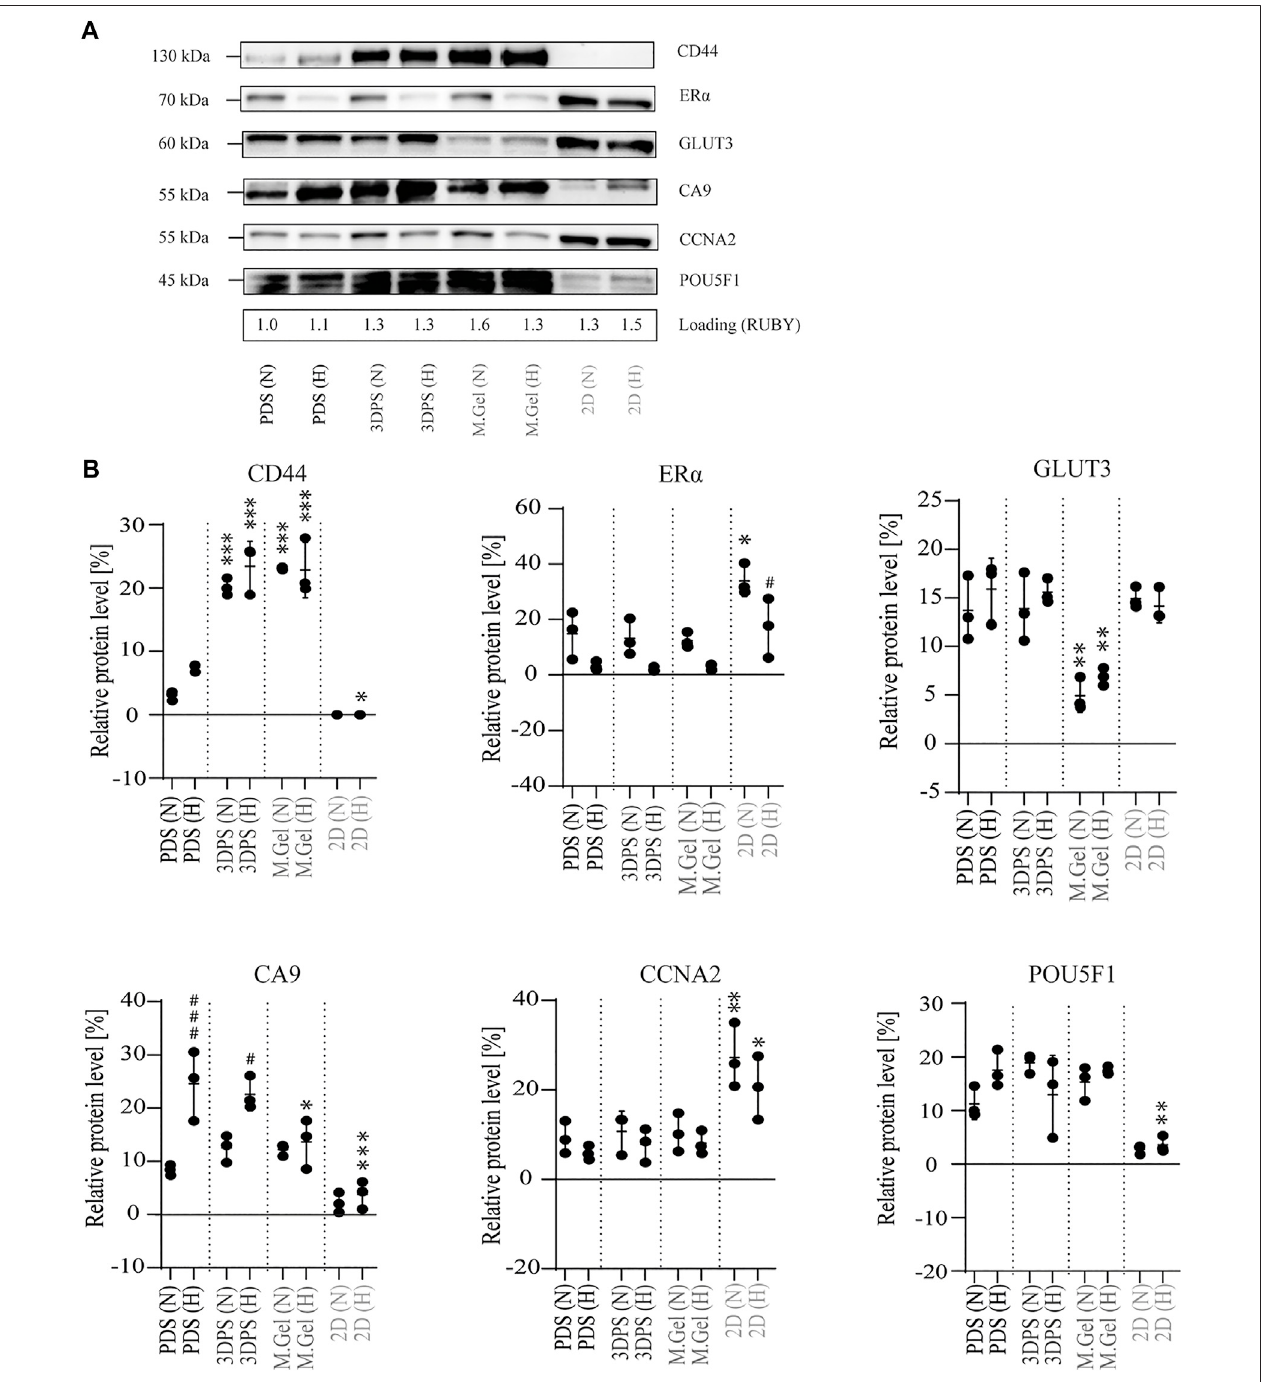
FIGURE 4 | Protein levels in MCF7 cells cultured in normoxia and hypoxia. (A) Representative Western blot image from total protein extracts of cells cultured in normoxia (N) or hypoxia (H) on patient-derived scaffolds (PDS), 3D printed scaffolds (3DPS), Matrigel (M.Gel), or in 2D. Protein ladder 45 – 130 kilodalton (kDa). Loading controlbySYBRORubystaining(RUBY). (B) Quanti fi cationofWesternblot( n (cid:2) 3)showingtheproteinamountrelativetotalproteinamount.Asterix(*)indicatesstatistical comparisonofrespectivegroupandPDS.Thehashsign(#)indicatesstatisticalcomparisonofnormoxiaandhypoxiaforrespectiveplatform.Thestatisticalmethod used was two-way ANOVA; Tukey ’ s post hoc test for multiple comparison; * ,# p -value < 0.05, ** p -value < 0.01, *** ,### p -value < 0.001.